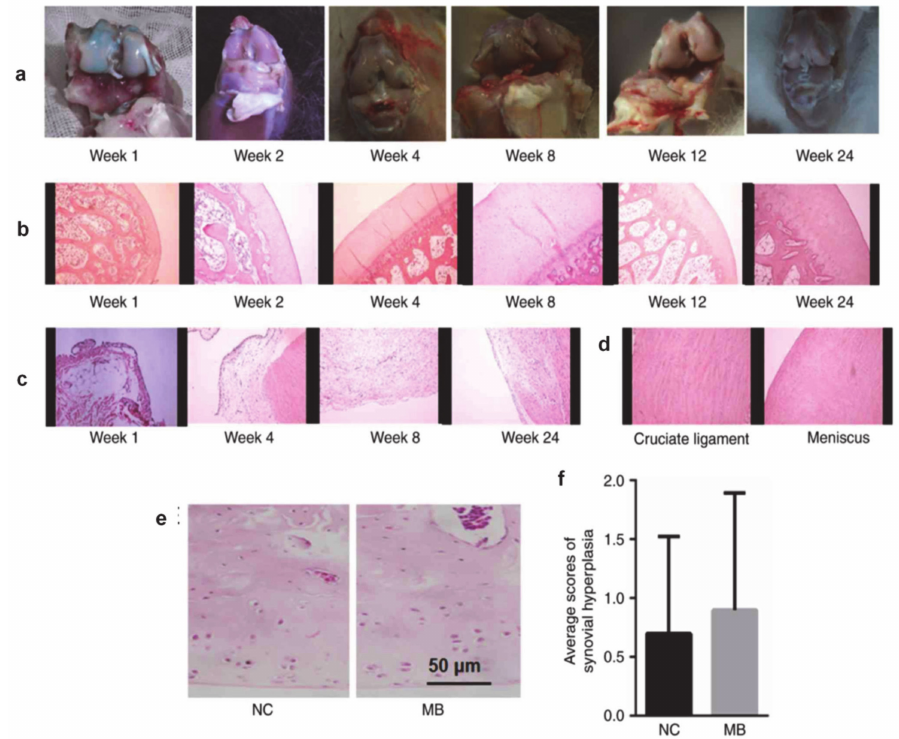
Figure 5. Intra-articular injection of MB is safe in rabbits. ( a ) No notable morphological changes were observed in rabbit articular cartilage at 1, 2, 4, 8, 12, and 24 weeks following MB injection. ( b ) The rabbit cartilage was intact, and the chondrocytes and matrix were normal at all time points, as indicated by hematoxylin and eosin staining at 100 × magnification. ( c ) No synovial hyperplasia was observed at 1, 4, 8, or 24 weeks following injection of 1 mg / kg MB into the rabbit knee joint cavities at 100 × magnification. ( d ) No lesions of the cruciate ligament or meniscus were observed 24 weeks following injection of 1 mg / kg MB into the rabbit knee joint cavities at 100 × magnification. ( e ) No histological characteristics of articular cartilage sections were observed in the MB or control groups 24 weeks following the injection of 1 mg / kg MB. ( f ) There were no significant di ff erences between the synovial hyperplasia scores of the control group and the MB group. MB, methylene blue; NC, normal control. Reprinted from [90] (open access reprint